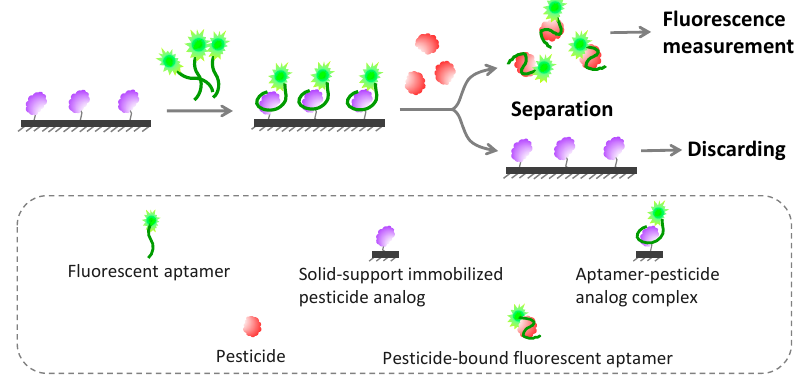
Figure 5. Schematic depiction of working principle of fluorescent pesticide aptasensors based on solid-phase immobilization.